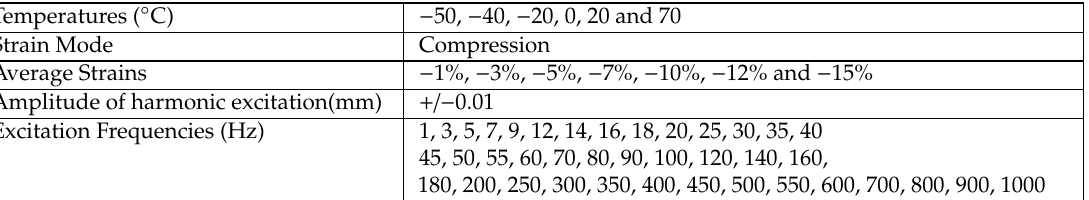
Figure 1. ( a ) Machine for universal tests MTS 831.50; ( b ) inside view of its thermal chamber. Table 1. Performance conditions for tests.